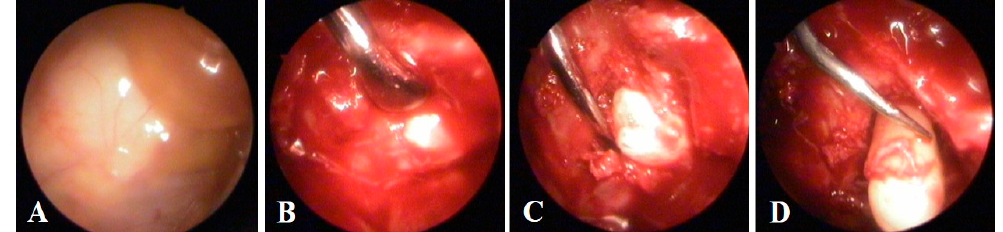
Figure 3. Intraoperative endoscopic images. A maxillary third molar embedded in the sinus mucosa was identified ( A ). After using a curette to expose the tooth ( B ), the tooth was luxated ( C ) and successfully removed with an elevator ( D ).